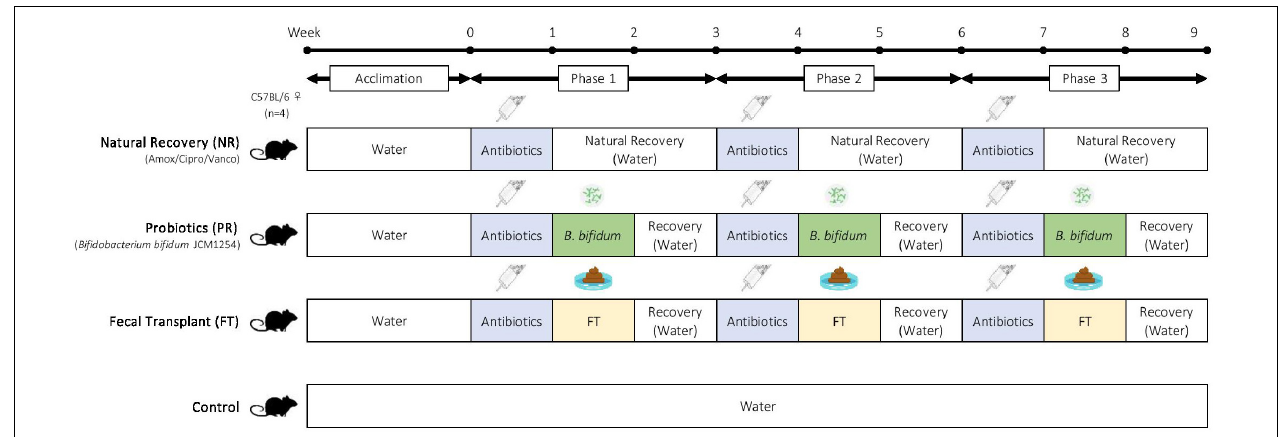
FIGURE 1 | Experimental design. Adult female C57BL/6 mice were used in this experiment, with four biological replicates per group. After 2 weeks of acclimation, mice were given one of the following antibiotics for one week: amoxicillin, ciprofloxacin, or vancomycin. Antibiotic treatment was followed by one of the following recovery treatments: natural recovery (NR); Bifidobacterium bifidum JCM1254 as a probiotic (PR); and fecal transplant (FT). The recovery treatment was followed by 7 days of no treatments to allow the mice to recover. Each 3-week cycle was repeated three times during this 9-week experiment. Mice in the control were provided with water alone throughout the